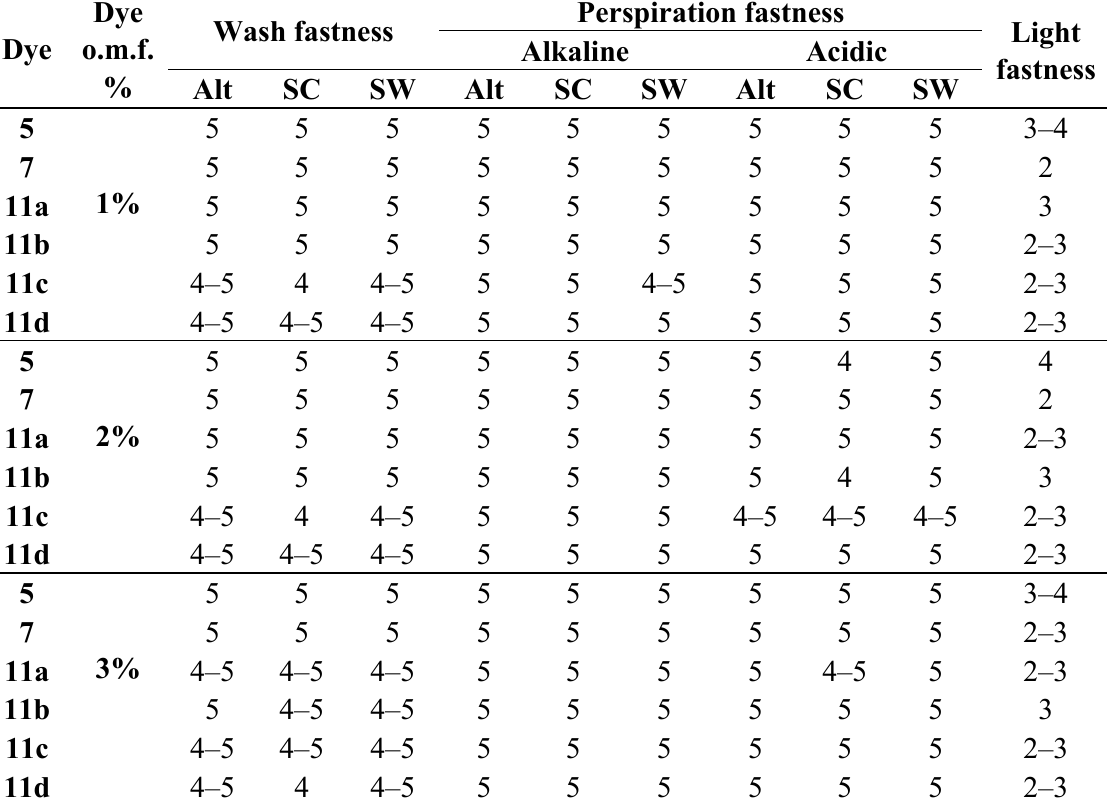
Table 3. Fastness properties of monoazo disperse dyes on polyester fabrics . Dye